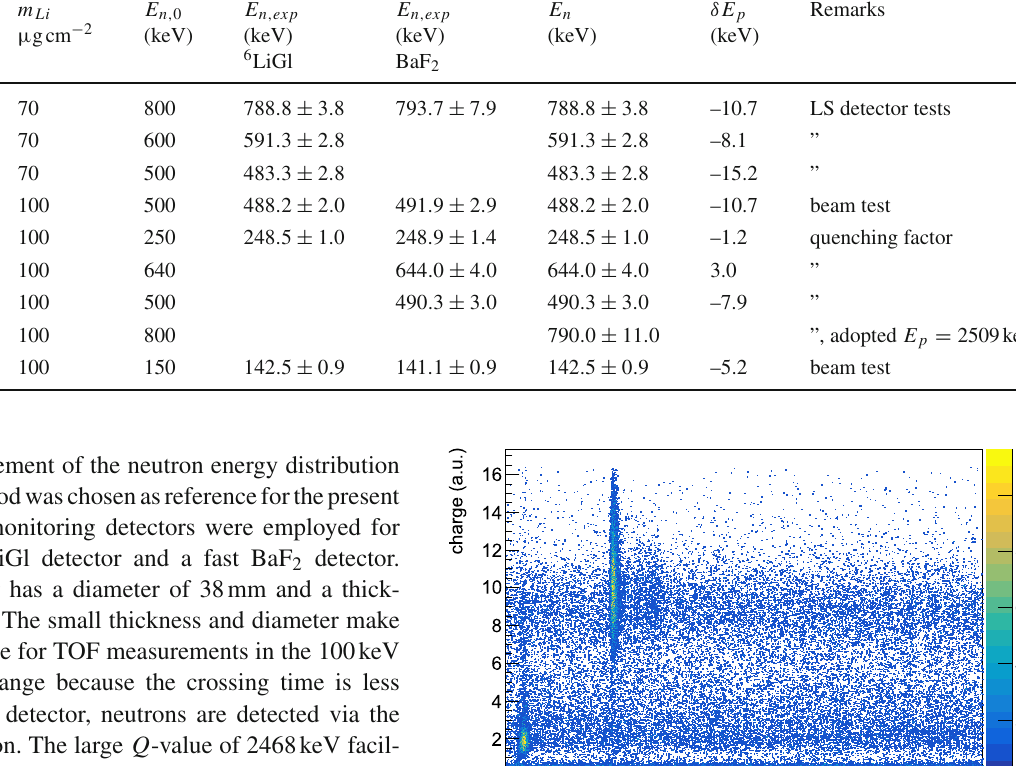
Table 1 Parameters of the neutron beams used for the characterisation of the LS detectors and for the measurement of the ionization quench- ing factors. The nominal proton and mean neutron energies are denoted by E p , 0 and E n , 0 , respectively. The experimentally measured neutron energy E n , exp from the two employed calibration detectors is reported